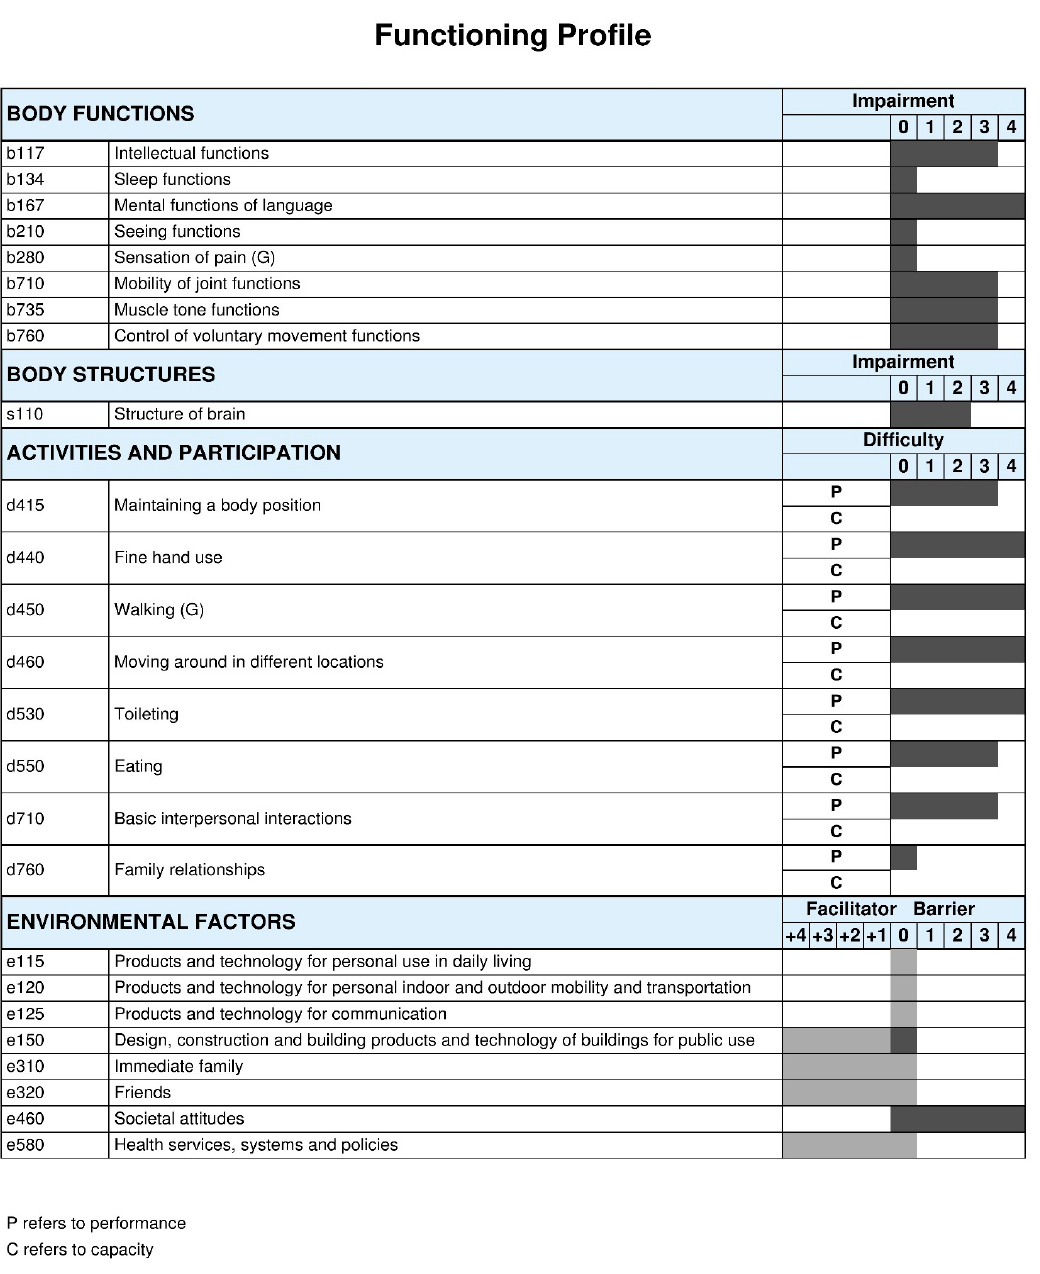
Figure 2. Functioning profile of the Brazilian children with cerebral palsy (CP). The ICF qualifiers use to create the profile of functioning of this study sample represent the qualifiers that have the highest percentage within each ICF category. This profile of functioning was built while using the ICF-based documentation form on this web page https://icf-core-sets.org/es/page0.php courtesy ICF Research Branch.